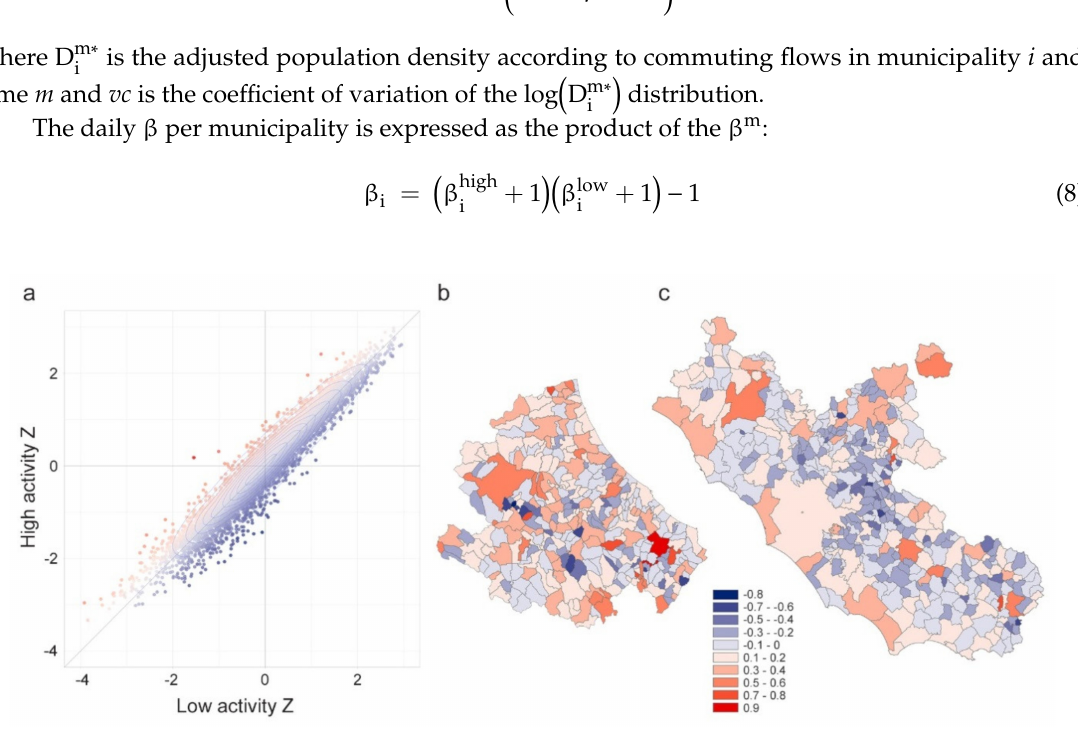
Figure 6. Panel ( a ) include the scatterplot of the Zscores for low-activity time ( x -axis) and high activity time ( y -axis). The color of the points codes the di ff erence y–x to diversify the municipalities where incoming commuters prevail over outgoing (red points) from municipalities where outgoing commuters prevail over incoming (blue points). Zscore di ff erence for ( b ) Abruzzi and ( c ) Lazio regions,